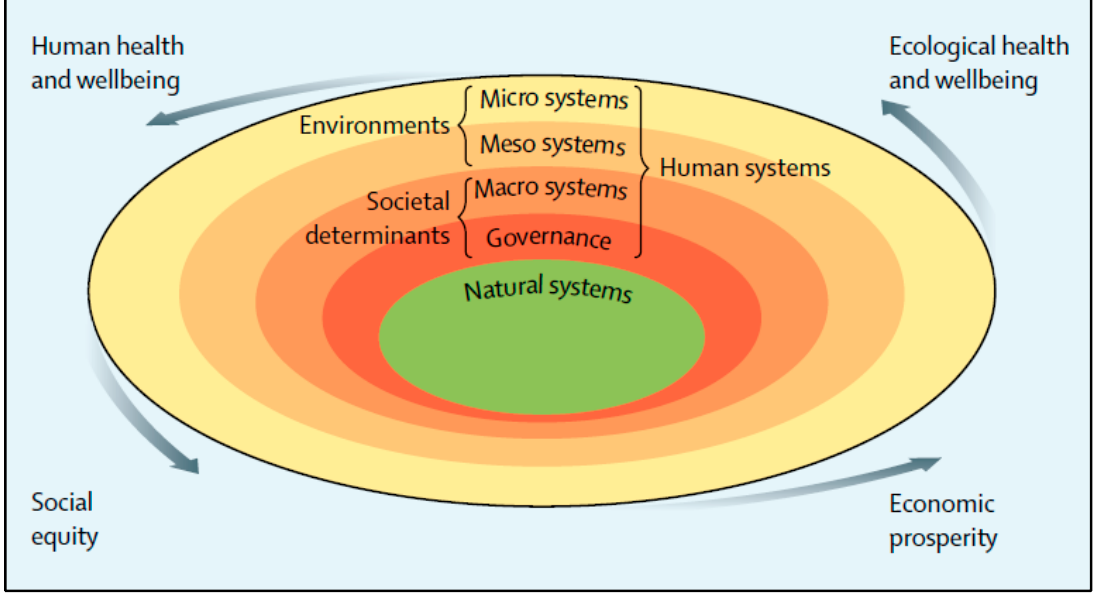
Figure 1. The systems outcomes framework showing the natural systems surrounded by the human systems with the four major consequences coming from these systems (from [4], reproduced with permission from Elsevier 2019).